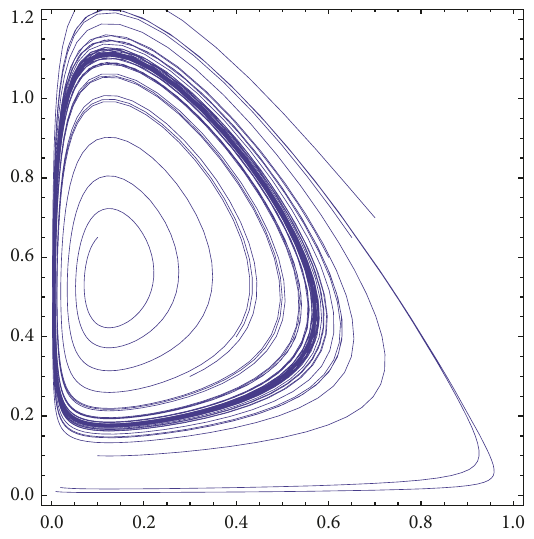
Figure8:Phaseportraitfor(1), 𝑚 = 1, 𝑟 = 1, 𝐴 = 0.5, 𝐾 = 1, 𝛾 = 1 , and 𝛿 = 0.5 .